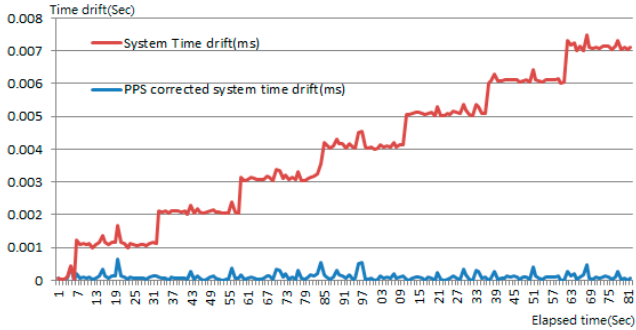
Figure 9. Correction to system time drift using the external PPS signal.